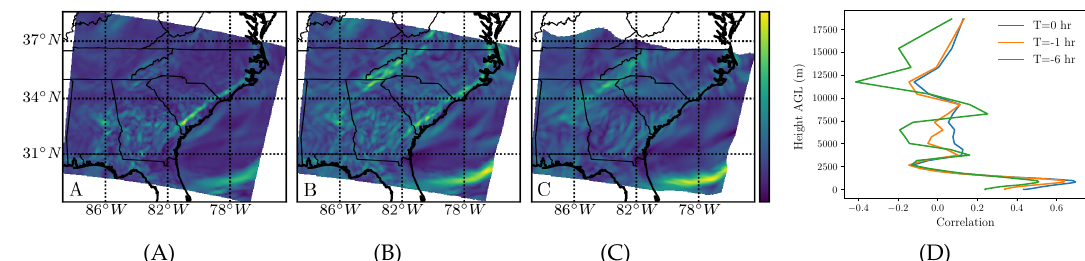
Figure 4. Backward-time FTLE field (relative scale) for the water vapor (H 2 O) generalized velocity field with integration times T of: ( A ) 0 h, ( B ) https://youtu.be/IKkD9ANZajg. In ( D ), the correlation coefficient between FTLE field from the species-weighted vertically-integrated velocity field and the FTLE fields for each individual vertical level for integration times of T = 0 h (blue), T =